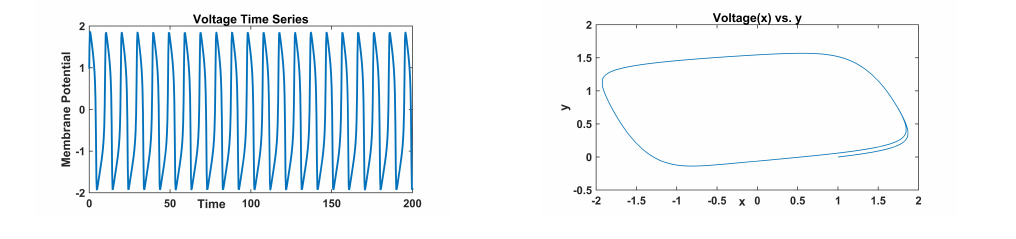
Figure 14. Recovery variable (right) with a constant external current value, I(t) = 2 µ A / cm 2 , a = 0.8 , b = 0.7 & c = 3